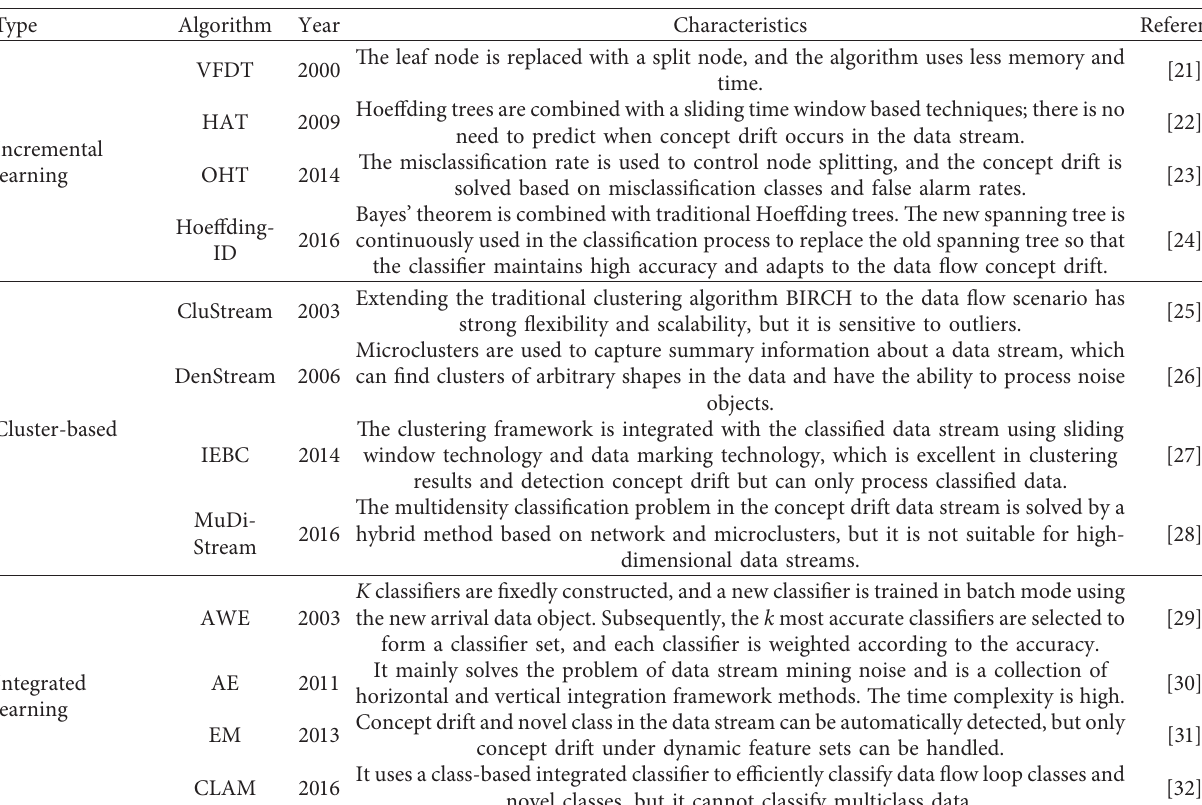
Table 1: Representative research achievements of concept drift data stream in